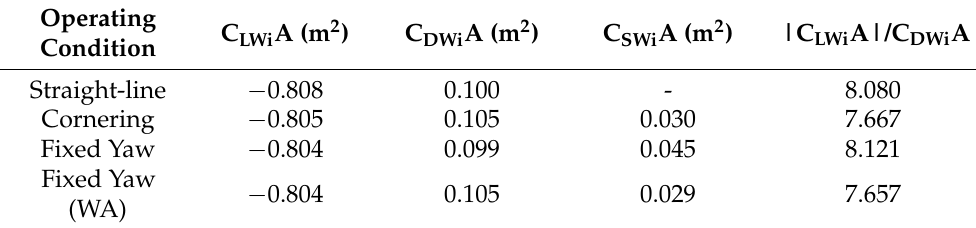
Table 2. A table showing the lift, drag and side-force areas as well as the efficiency values obtained under all three